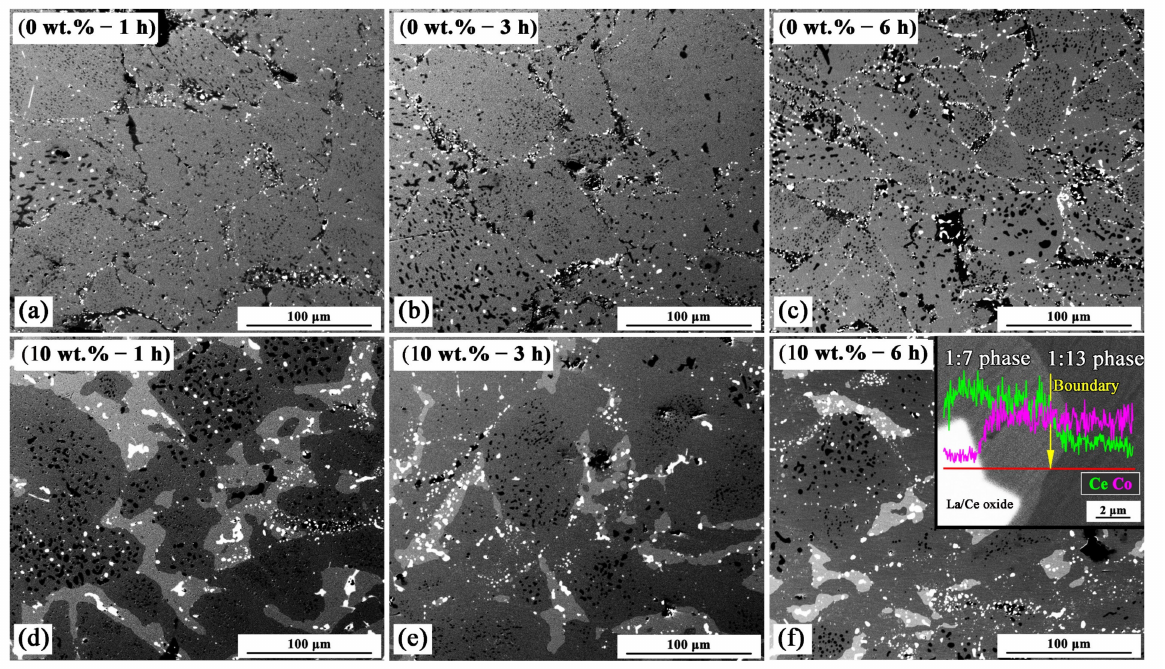
Figure 3. Backscattered SEM micrographs of binder-free LaFe 11.6 Si 1.4 composites ( a – c ) and LaFe 11.6 Si 1.4 /10 wt.%Ce 2 Co 7 composites ( d – f ) sintered at 1373 K for 1, 3 and 6 h, respectively. The inset of Fig.3(f) shows the line scan results of the interphase boundary between the 1:13 phase and the 1:7 phase for LaFe 11.6 Si 1.4 /10wt.%Ce 2 Co 7 composites sintered at 1373 K for 6